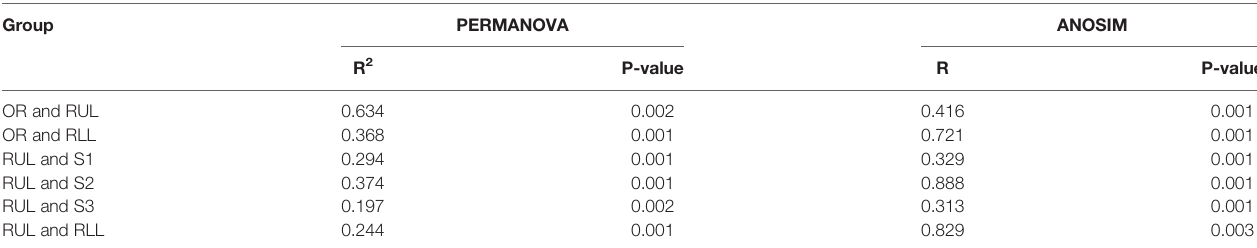
TABLE 3 | PERMANOVA and ANOSIM analysis for community structures.